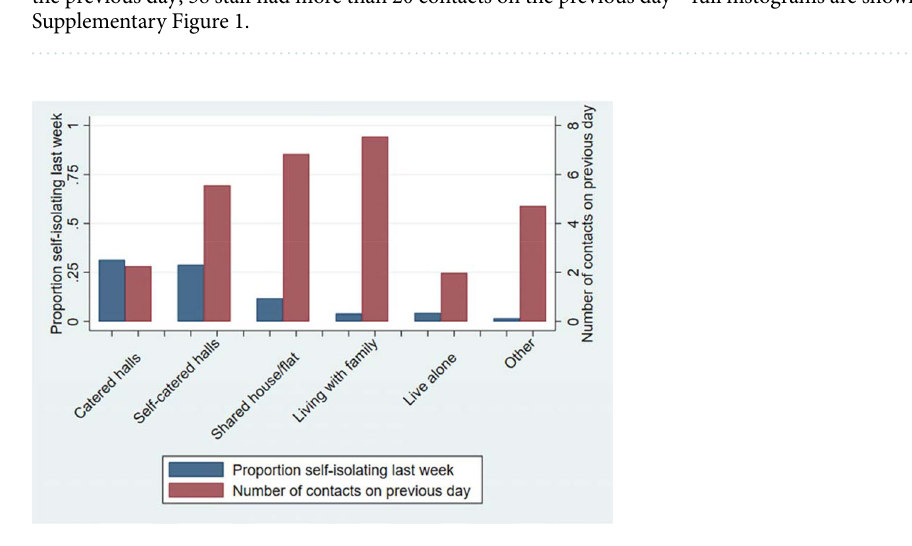
Figure 2. Mean number of contacts on the previous day and the proportion of people self-isolating within the prior week by residence